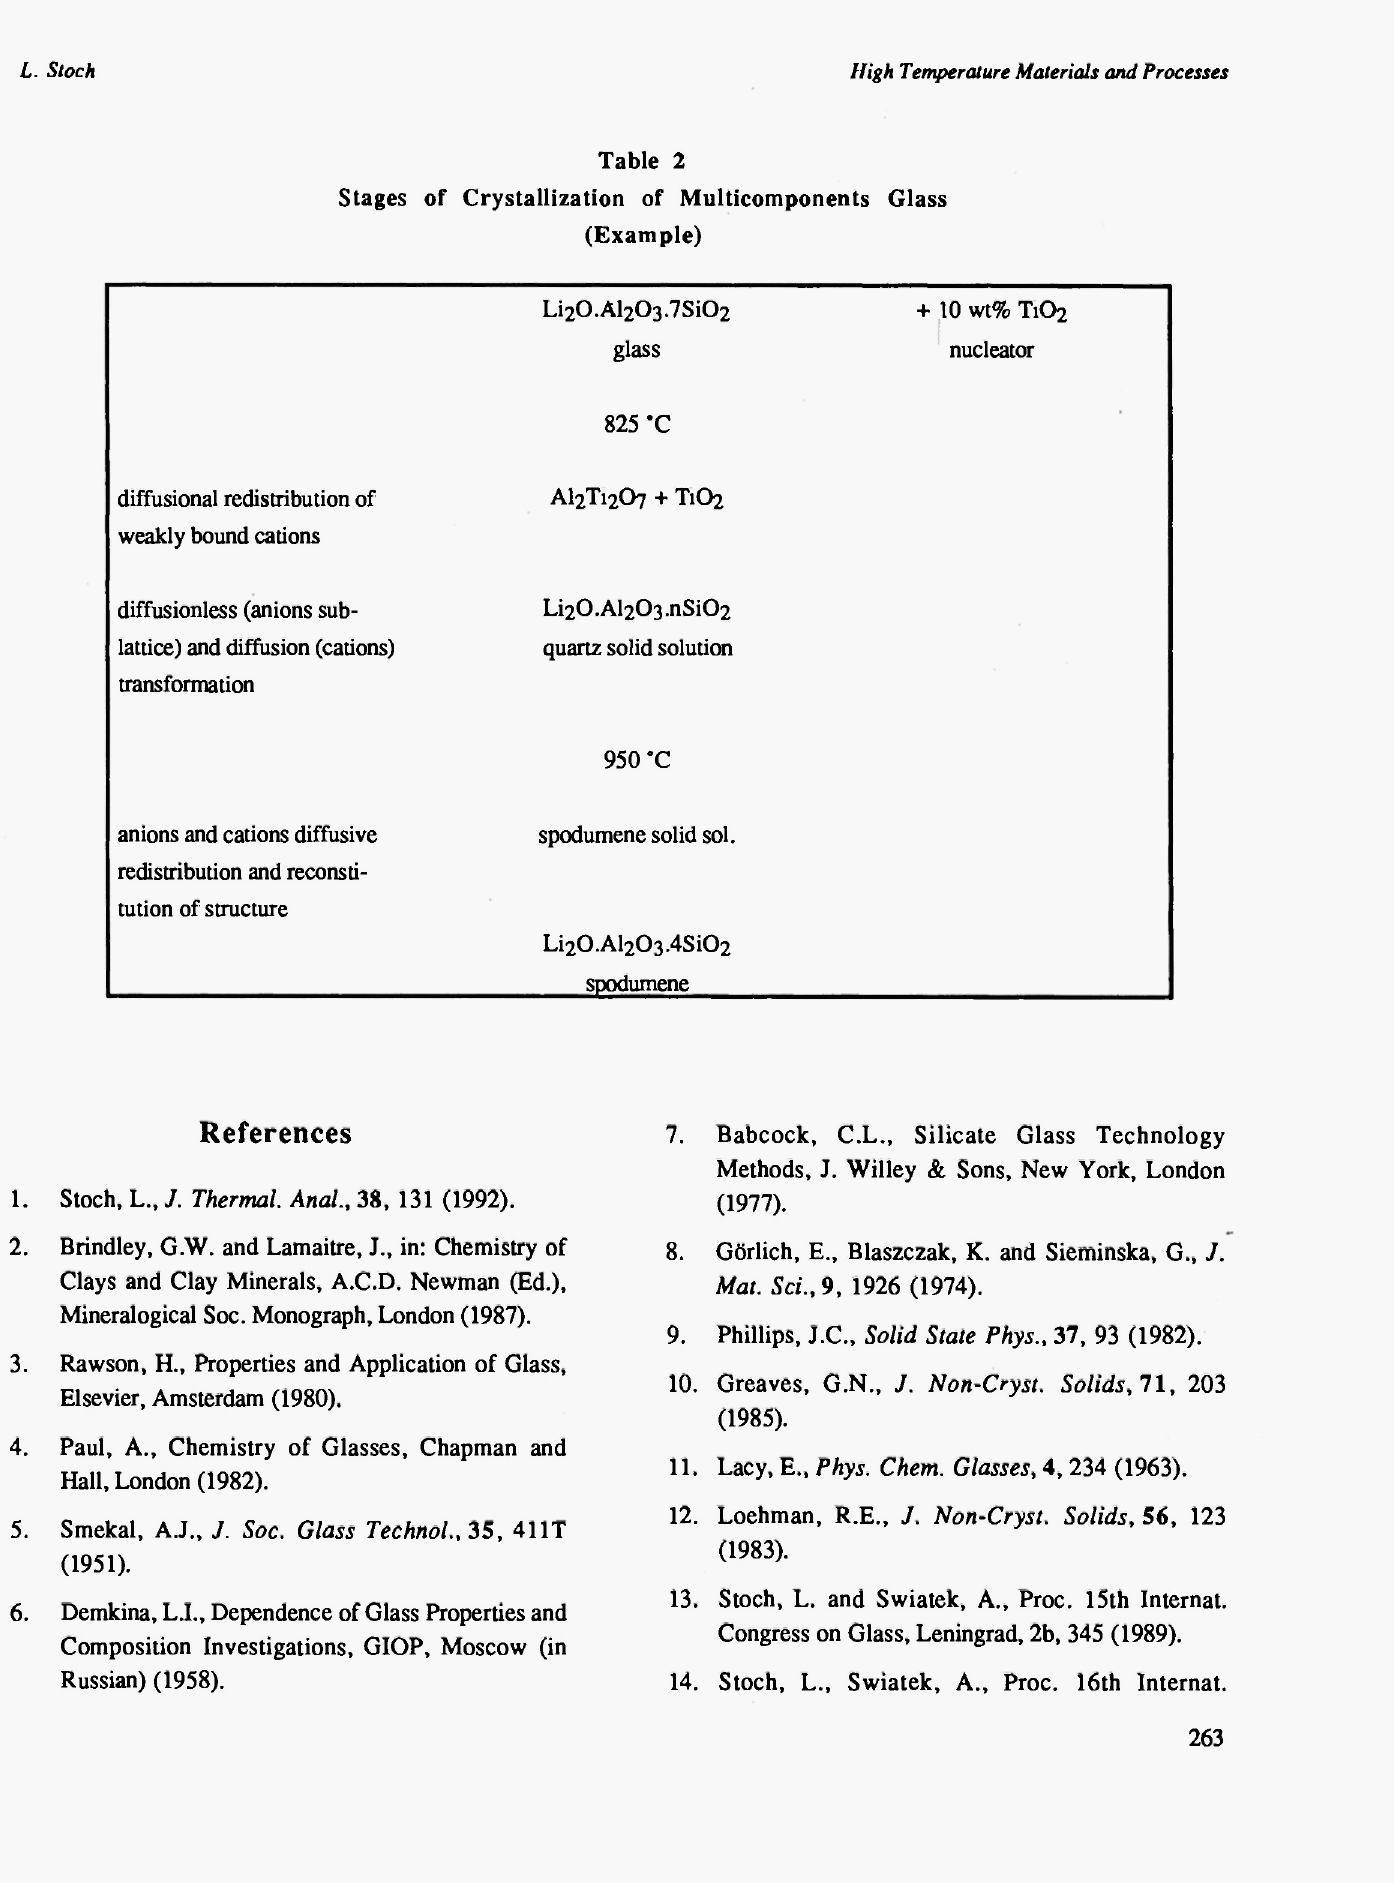
Stages of Crystallization of Multicomponents